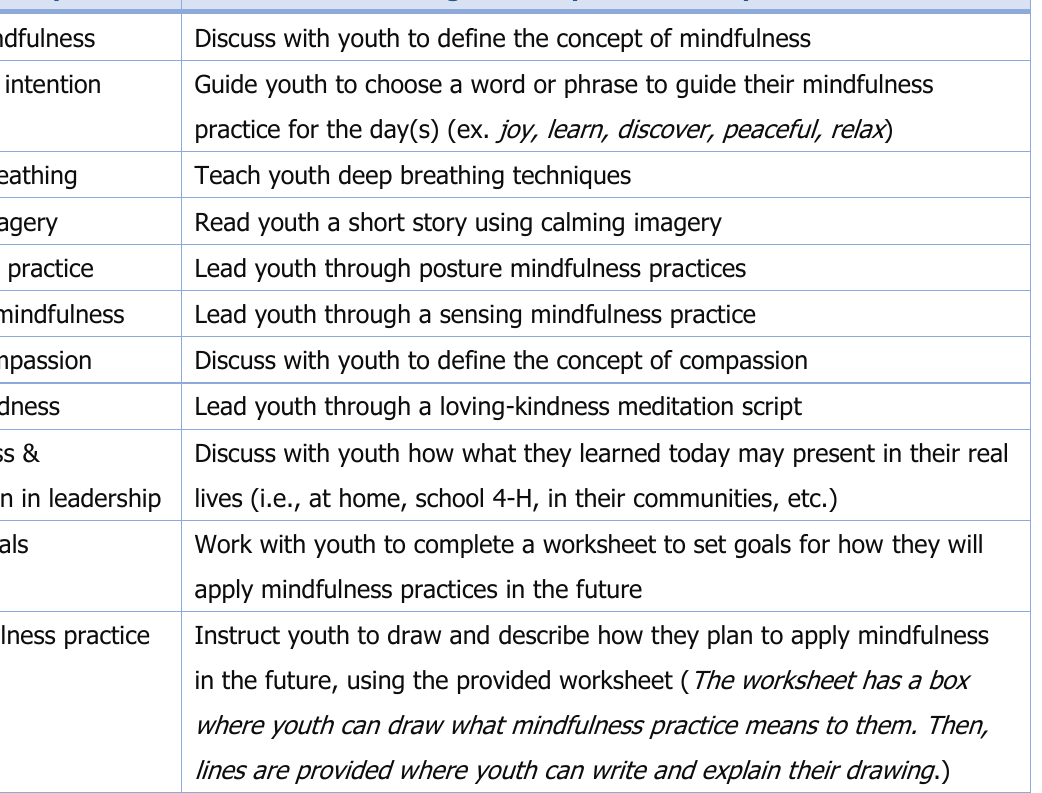
Table 1. Mindfulness Moments: Today and 4-Life Program Components Program